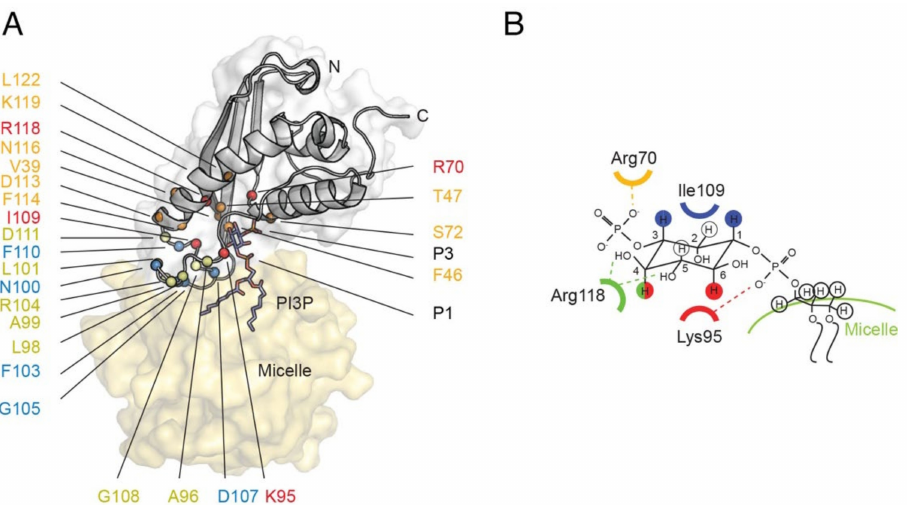
Figure 8. Structure of the Snx3 PX domain docked to a PI3P-contain micelles. ( A ) The Snx3 backbone (PDB: 2MXC) is grey with DPC micelle shown as a yellow surface; key residues are labelled and interactions with the PI3P headgroup are shown in ( B ). Residues which exhibit significant chemical shift perturbations upon interaction with the PI3P headgroup or micelles are coloured orange or yellow, respectively, while those exhibiting intermolecular interactions with PI3P or DPC are also displayed in red and blue, respectively [116] The phosphate groups of PI3P are indicated by P1 and P3, and hydrogen bonds are shown with dotted lines. Used by permission from